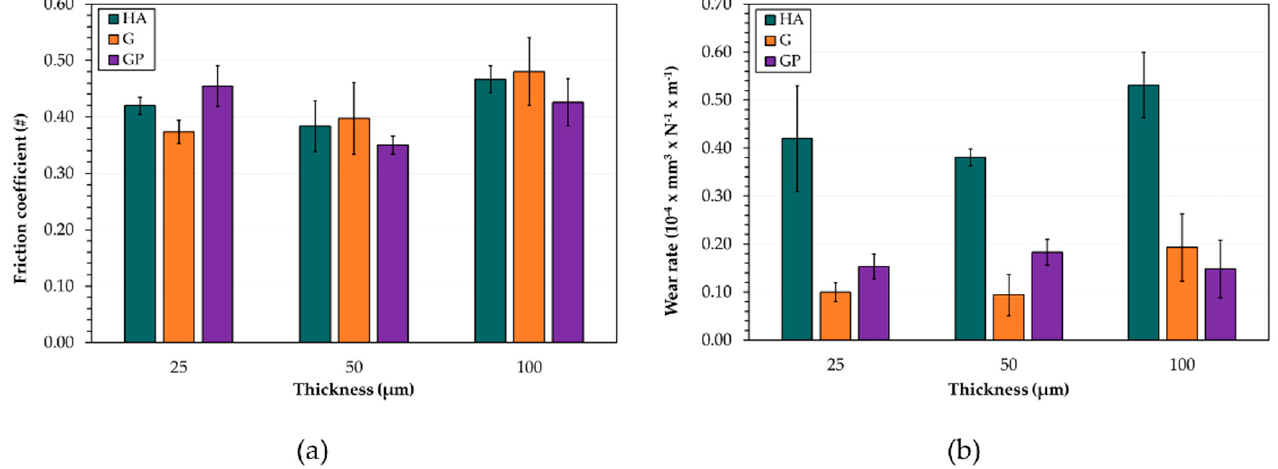
Figure 8. Mean values ± standard deviations of ( a ) friction coefficient and ( b ) wear rate for all anodizing treatments and thicknesses of anodic aluminum oxides.